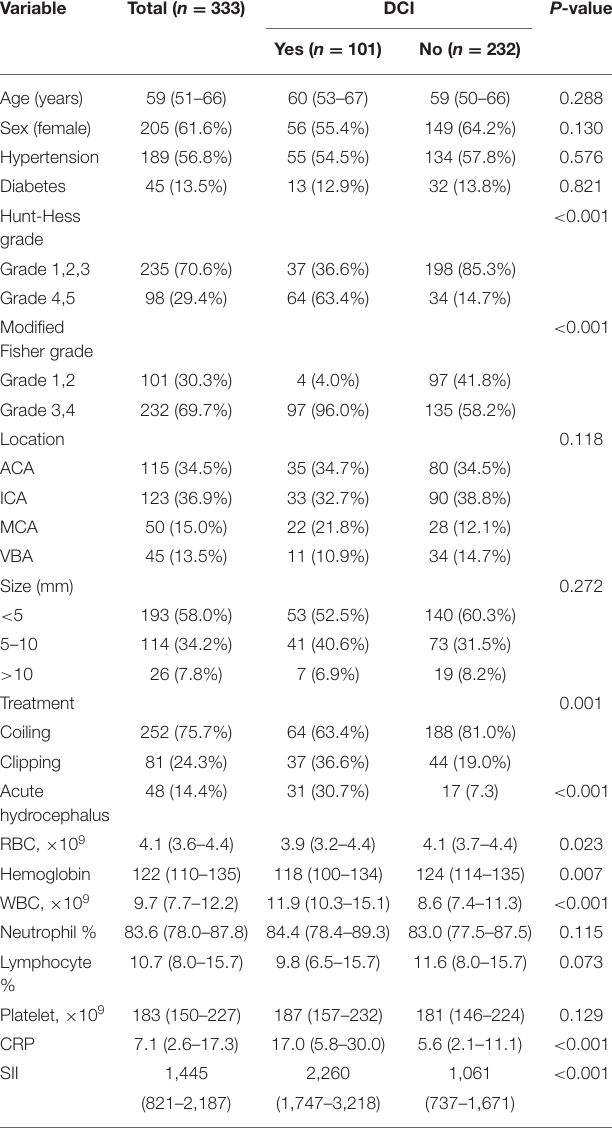
TABLE 2 | The univariate and multivariate logistic analysis of predictors for delayed cerebral ischemia. Predictors Univariate analysis Multivariate